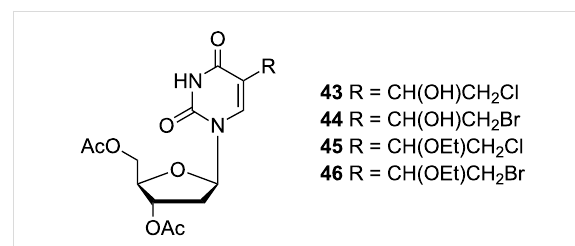
Figure 5: 5-(1-Hydroxy(or ethoxy)-2-haloethyl)-3',5'-di- O -acetyl-2'- deoxyuridines 43 – 46 .